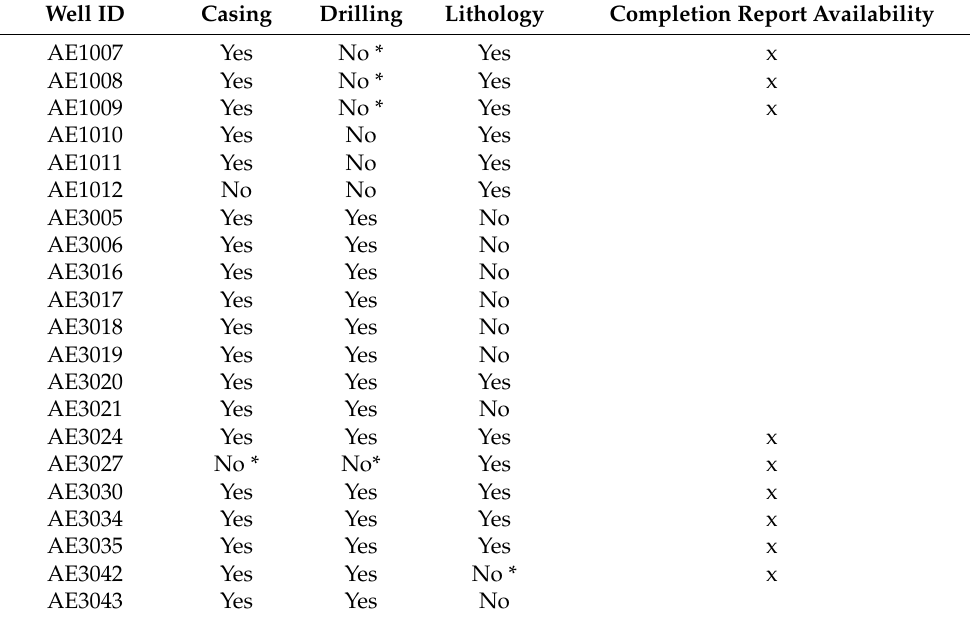
Table 2. Availability of casing, drilling and lithology data and drilling completion reports of the Wadi Al Arab wells. Well ID Casing Drilling Lithology Completion Report